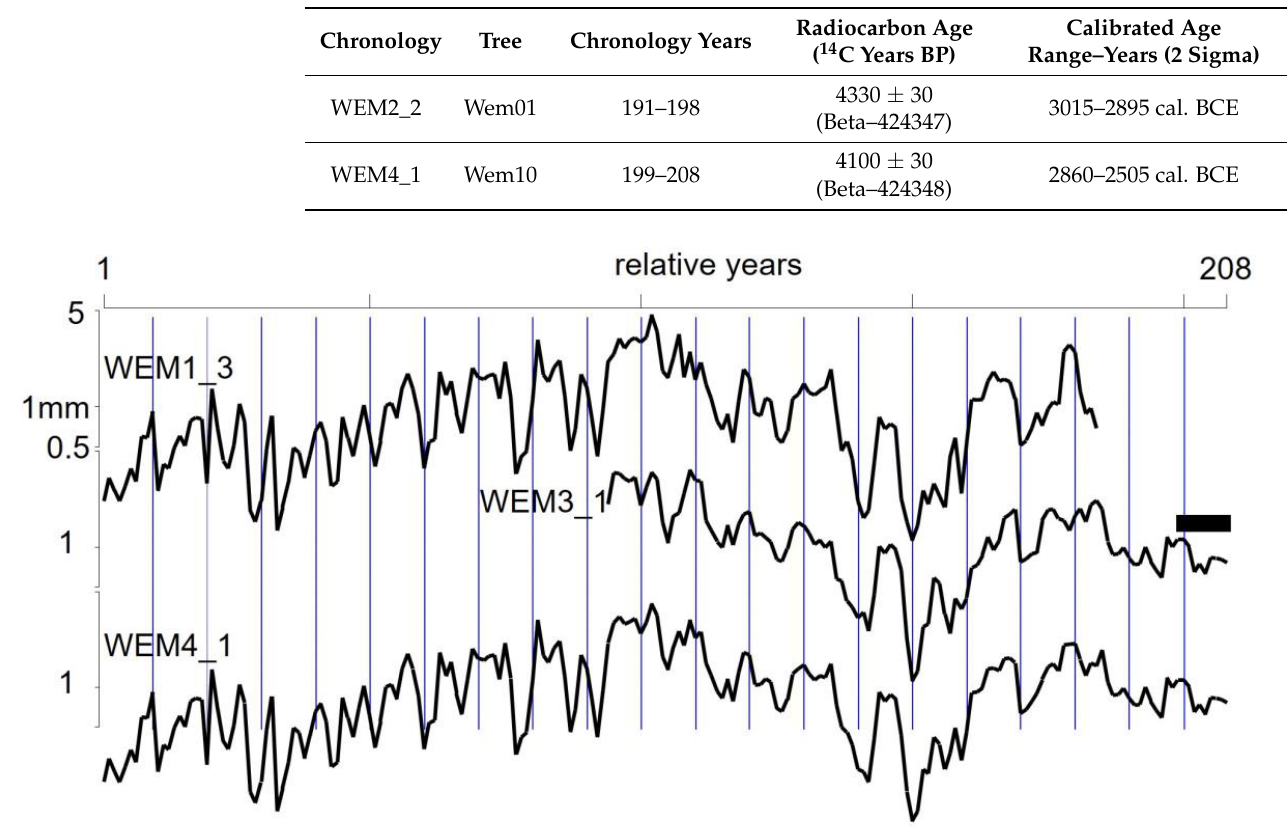
Table 3. Radiocarbon dates associated with samples from chronologies Wem2_2 and Wem4_1.